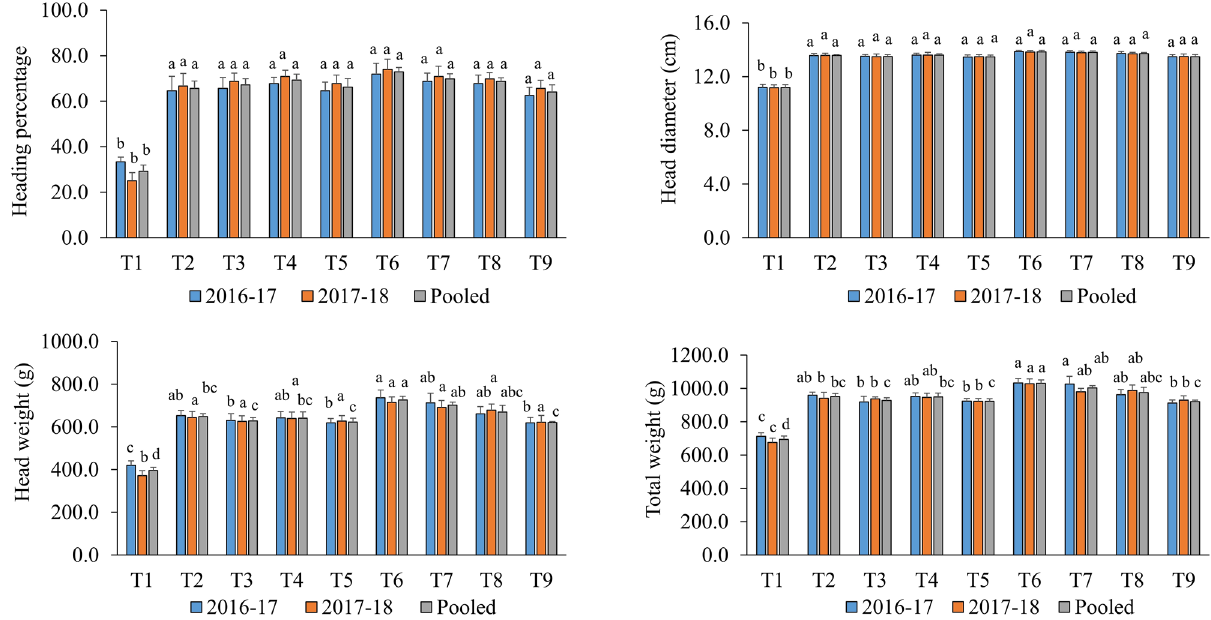
Figure 2. Effect of bio-priming and fertilization on yield attributes of red cabbage. Bars (mean ± SE; n = 3) followed by different alphabets significantly differ ( P ≤ 0.05) among the treatments as per DMRT. Treatments: T 1 : Absolute control N:P 2 O 5 :K 2 O @ 0:0:0 kg ha −1 ; T 2 : RDF of N:P 2 O 5 :K 2 O @ 120:60:60 kg ha −1 ; T 3 : 75% RDF + Trichoderma harzianum ; T 4 : 75% RDF + Pseudomonas fluorescens ; T 5 : 75% RDF + Bacillus subtilis ; T 6 : 75% RDF + T . harzianum + P . fluorescens ; T 7 : 75% RDF + P . fluorescens + B . subtilis ; T 8 : 75% RDF + T . harzianum + B . subtilis ; T 9 : 75% RDF + T . harzianum + P . fluorescens + B .